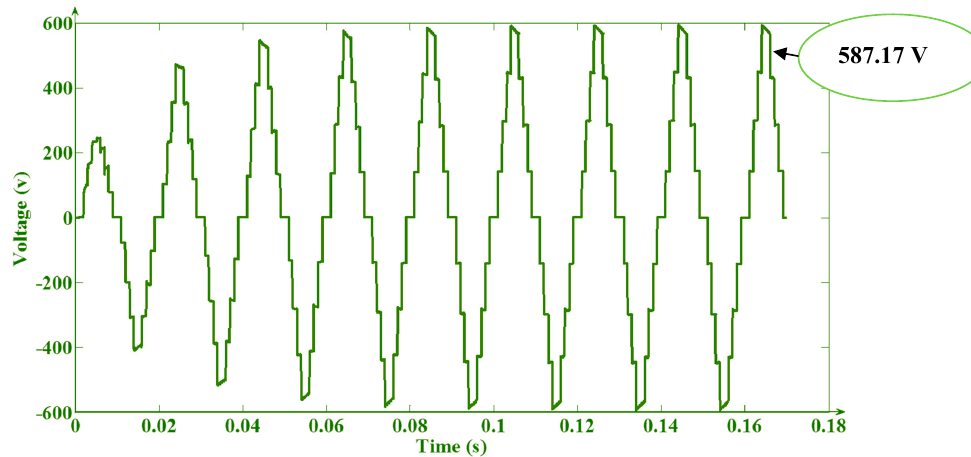
Figure 45. Output voltage for MLI with hybrid controller circuit-based BDC.